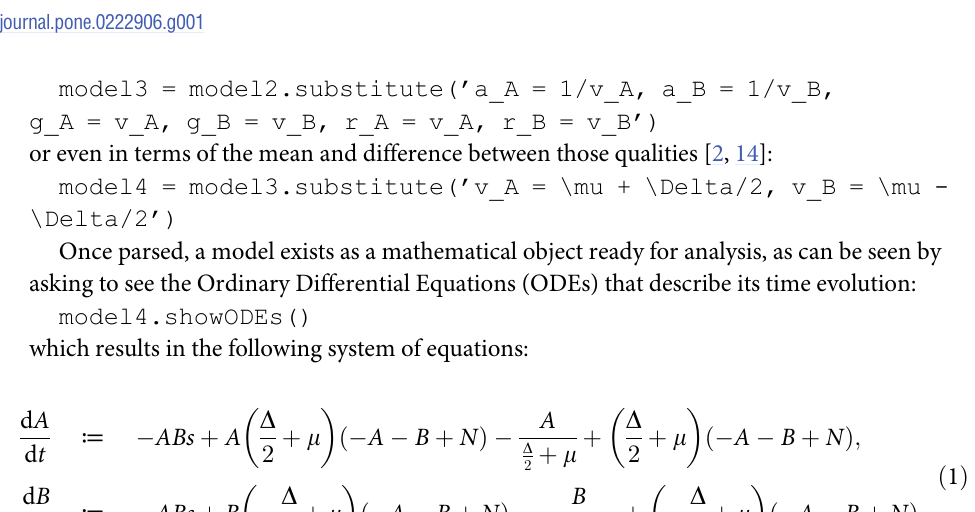
Fig 1. Specification of a collective behaviour model. A model is described using simple textual rules denoting interactions between reactants in the system, and rates and which they are transformed into new combinations. Parsing this model description automatically results in a mathematical model object ready for